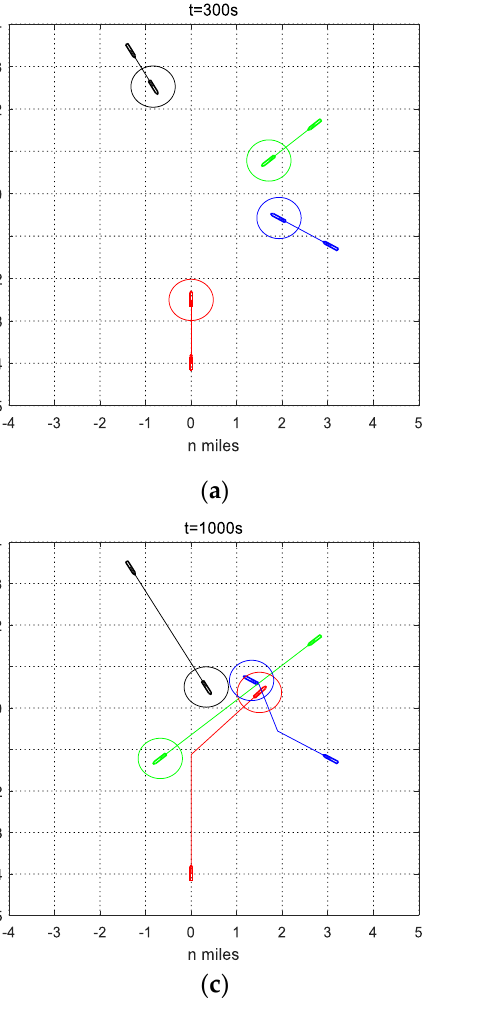
Figure 9. Ships' trajectories under scenario 3: ( a ) the positions and paths of ships at 300 s, ( b ) the positions and paths of ships at 700 s, ( c ) the positions and paths of ships at 1000 s and ( d ) the positions and paths of ships at 1500 s.